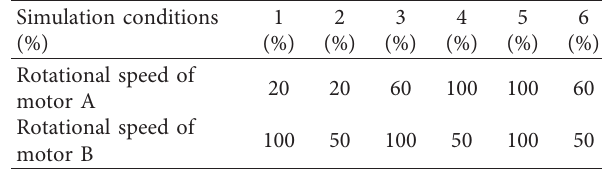
Figure 9: Errors of the proposed and classic OTPA in the response synthesis.